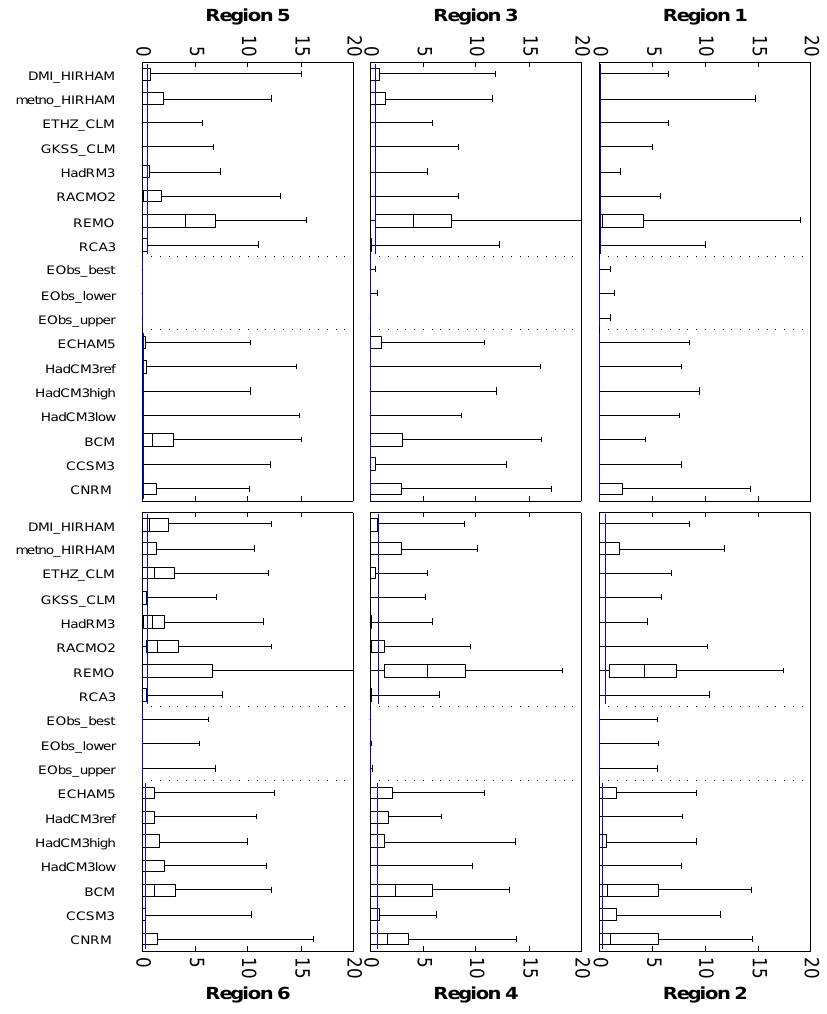
Fig. 5. CHM maximum frost damage during spring, units are degrees. The organisation and layout of the graphs is the same as for Fig. 3. (late start) and SBI, yet a very small negative bias in number of events and even a small positive bias in minimum tem- peratures. We note that the deviations of the RCA3 ERA40 ensemble member are comparatively small for all four vari- ables and in all six regions, thereby providing a good basis for assessing the climate change signal. We also stress that the SBI model has not been calibrated or adjusted to fit the RCA3 input